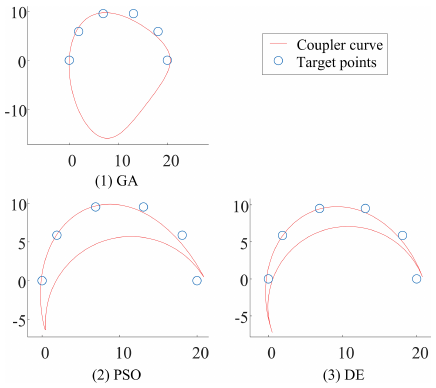
Figure 8. Coupler curves obtained in this study for Example 2.